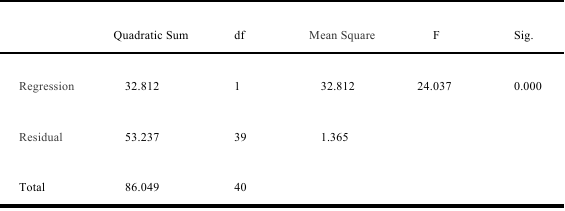
Table 4. The ANOVA of H- α curve